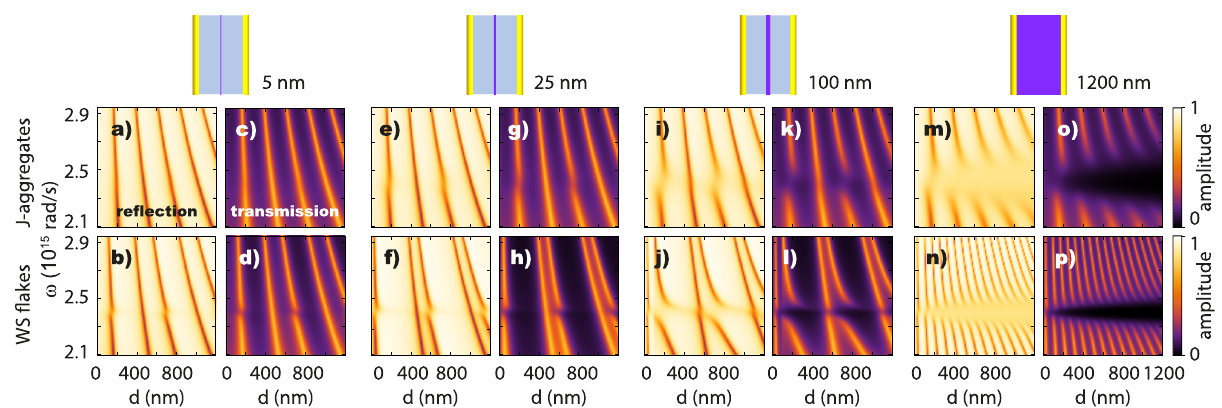
Figure 11: Calculated reflection and transmission for Fabry – Pérot etalons with an increasing thickness d exc of excitonic material placed in its center (from left to right: 5, 25, 100 nm and completely fi lled), as a function of total etalon width d and frequency ω . The top row is for J-aggregates (values from Ref. [45]) while the bottom row is for WS 2 (values from model reported in Ref. [42]). For the fi rst three panels only d > d exc should be considered.